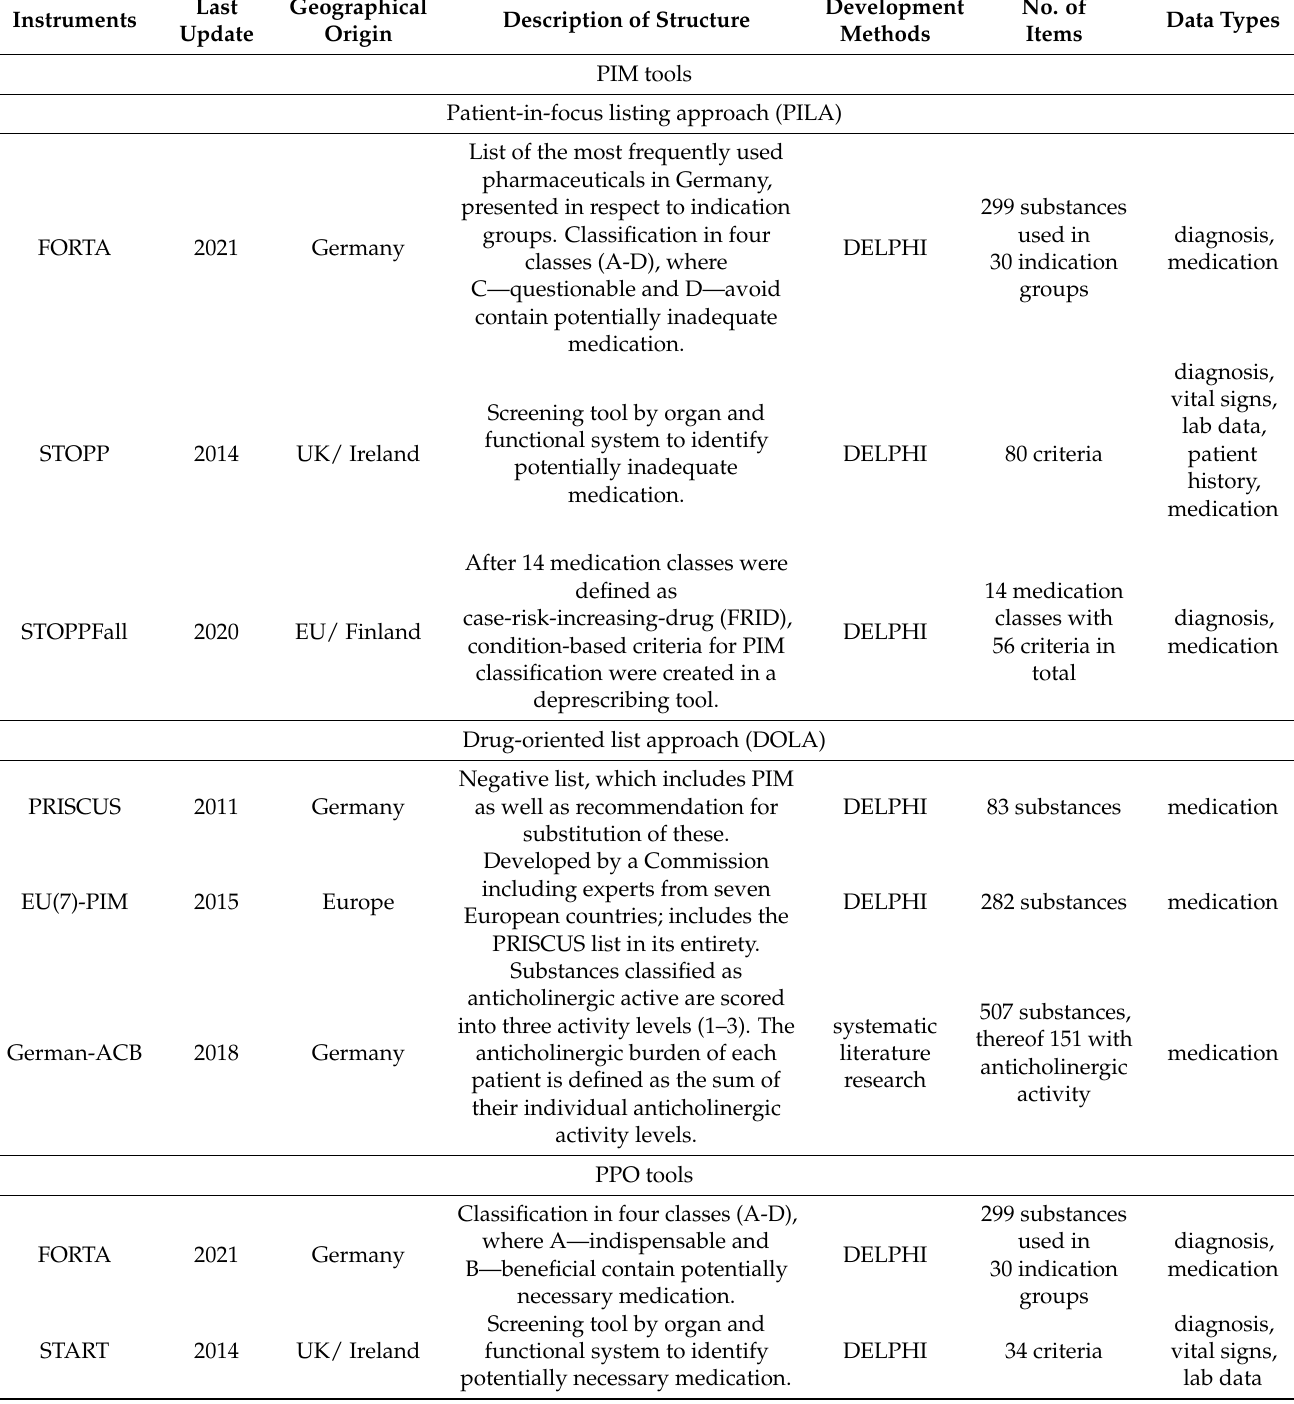
Table 1. Description of applied PIM and PPO